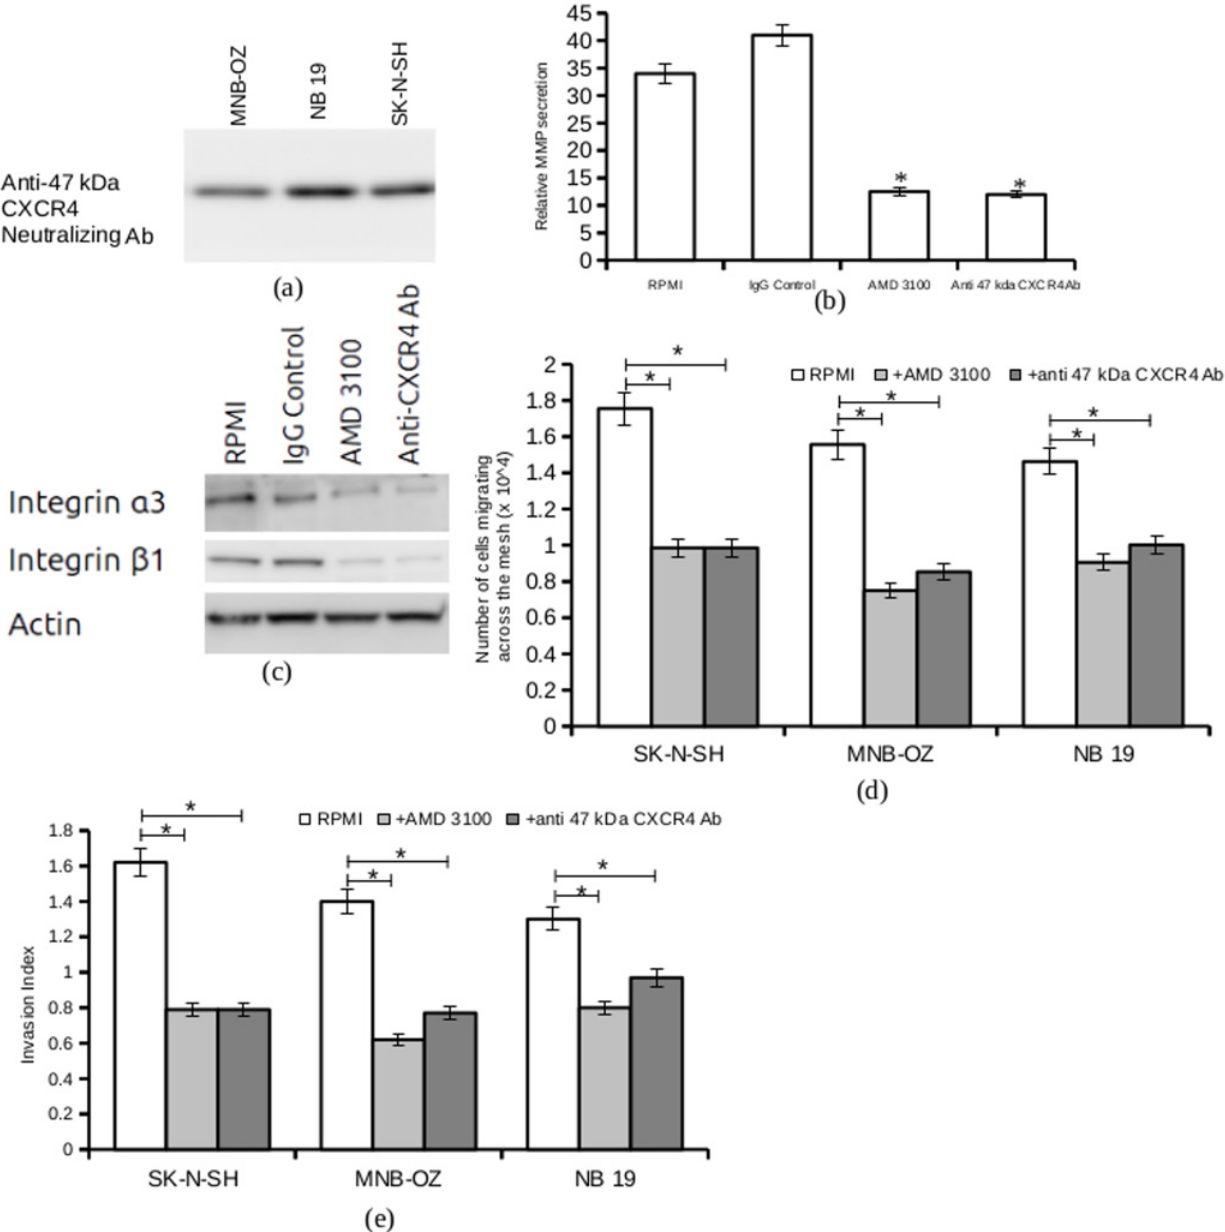
Fig 5. CXCR4 blocking assays. a. Total cell lysate from MNB-OZ, NB 19 and SK-N-SH cells were electrophoresed and blotted on to PVDF membrane, and protein detection was carried out with anti-47 kDa neutralizing antibody. Shown in figure is the representative result from 5 experiments. b. 80% confluent SK- N-SH cells were harvested and incubated in either RPMI, RPMI + IgG control, RPMI + AMD 3100 or RPMI + anti-47 kDa neutralizing antibody. The supernatants were harvested after 24 hours, centrifuged and subjected to gelatin zymography. The gels were analyzed using imageJ and the relative MMP-9 secretion was calculated from 3 experiments ( * p < 0.05). c. Total cell lysates from SK-N-SH cells either serum-starved (control), treated with IgG control (negative control), RPMI + AMD 3100 or RPMI + anti-47 kDa neutralizing antibody was subjected to western blot analysis. Protein detection was carried out with anti-integrin α 3 or anti-integrin β 1 antibodies. Anti-actin antibody was used for loading control. Shown in figure is the representative result from 3 experiments. d. Transwell invasion studies were carried out with cell lines SK-N-SH, MNB-OZ and NB 19. Cells were serum-starved (control), treated with 10 μ M AMD 3100 and treated with anti-47kDa CXCR4 neutralizing antibody. Plotted is the mean number of cells migrating across the mesh. ( * p < 0.05) e. Invasion index of cell lines SK-N-SH, MNB-OZ and NB 19, serum-starved (control) and treated with AMD 3100 and anti-47 kDa CXCR4 neutralizing antibody, were analyzed using transwell invasion assays. Plotted is the normalized invasion index values obtained from 5 experiments ( * p < 0.05).